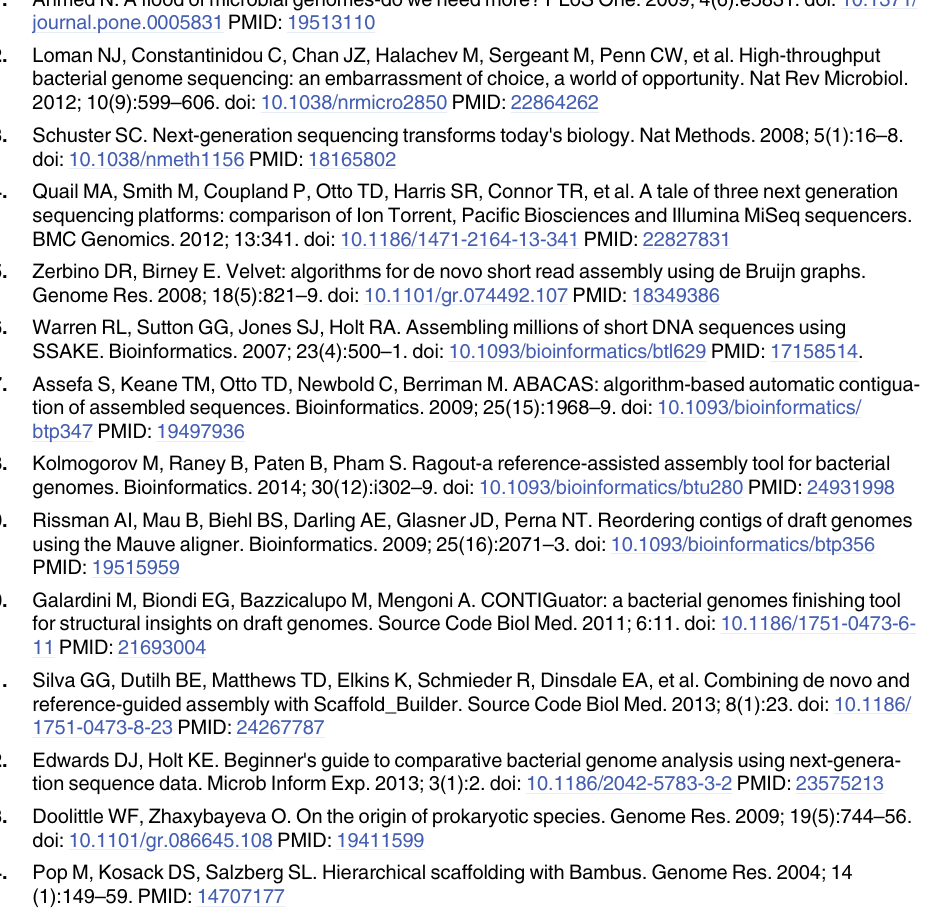
S5 Table. BLAST output of intra-contig repeat from CLA result in simulated S . Typhi Ty2 data against the original Ty2 genome. The positions tabulated depict that a ~600bp intra- contig repeat is present at 26 different locations in the original genome